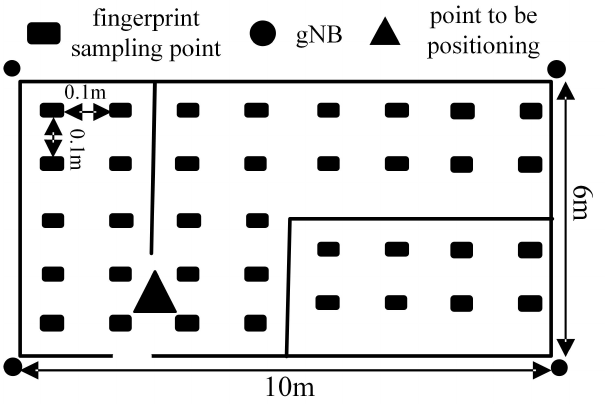
Figure 10. Schematic diagram of fingerprint sample collection in room